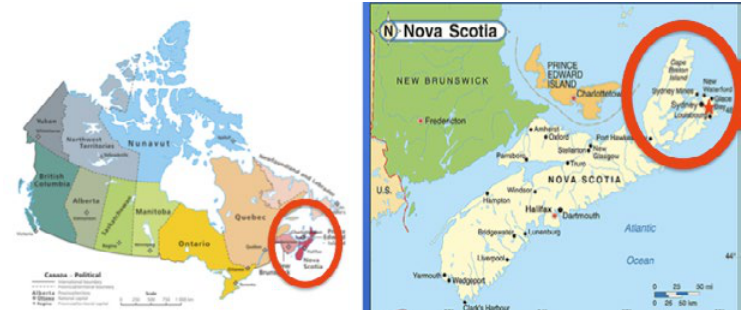
Figure 1. Map of Cape Breton